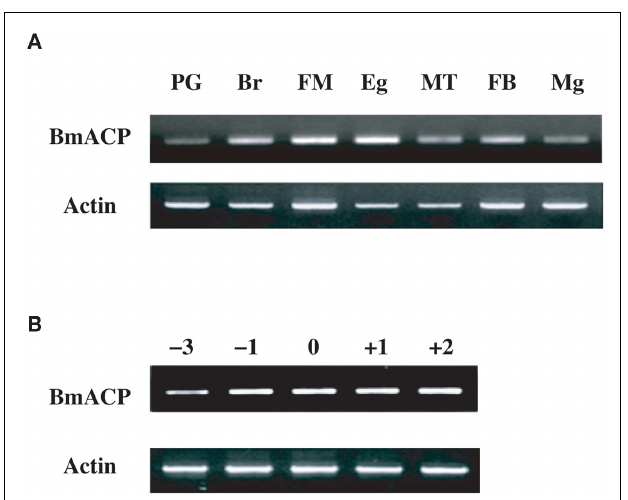
FIGURE 3 | Multiple sequence alignment of BmACP and related proteins. The predicted protein sequence of BmACP is compared with those of the Aedes aegypti , Anopheles gambiae , Drosophila melanogaster , and Mus musculus proteins (GenBank accession numbers: DQ443383, EAT36207,